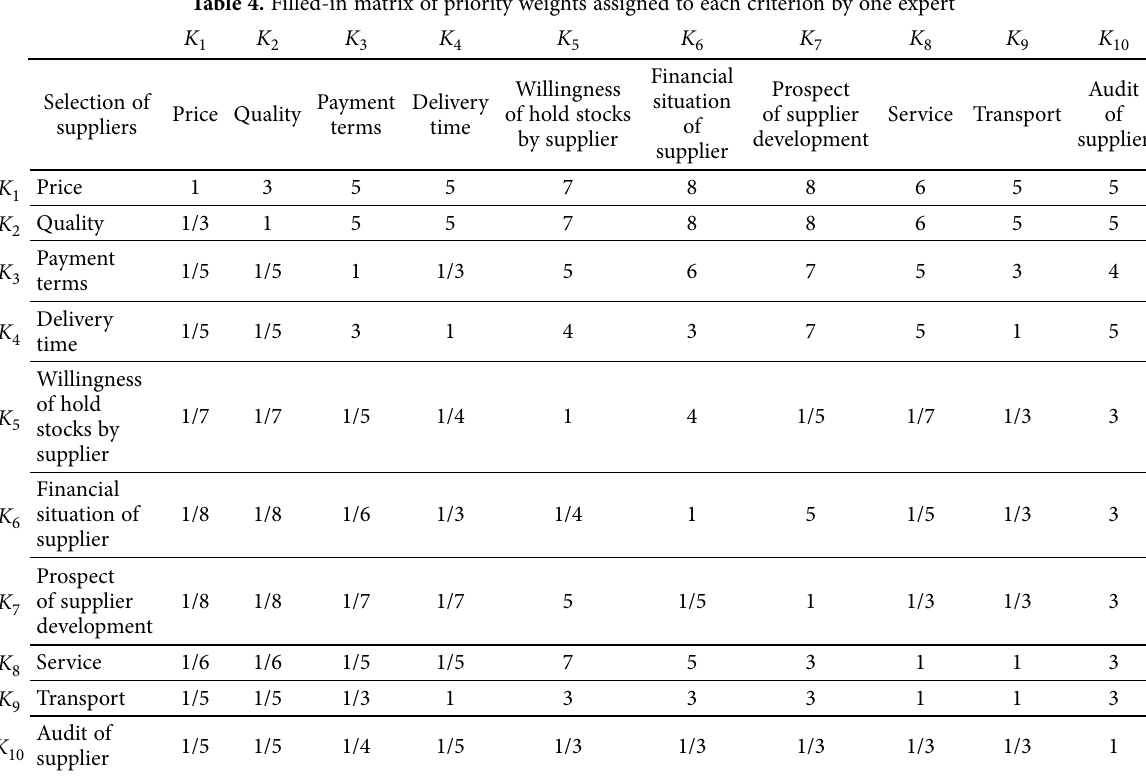
Table 4. Filled-in matrix of priority weights assigned to each criterion by one expert K